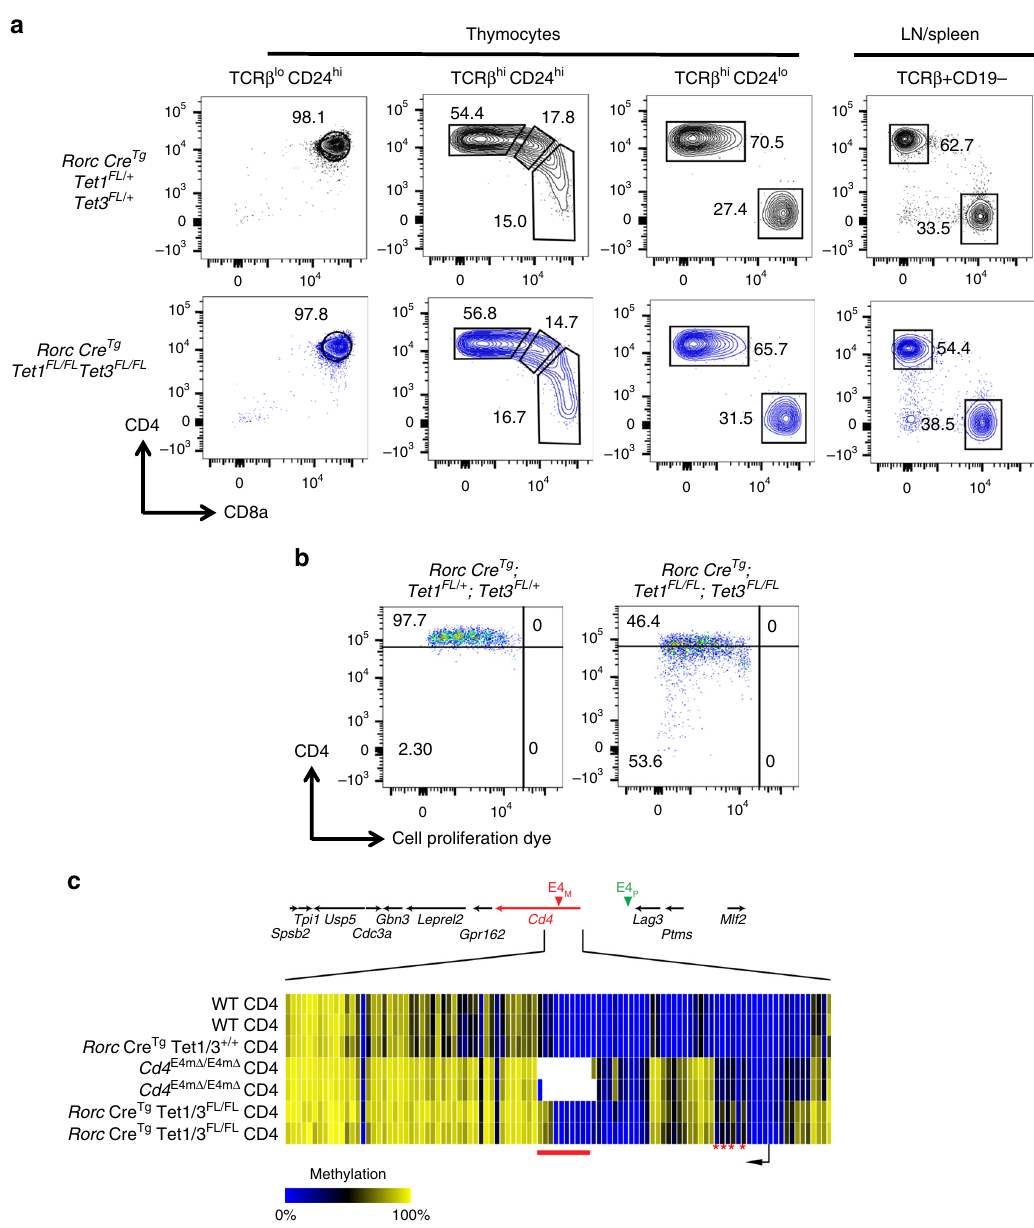
Fig. 6 TET1 and TET3 are required for E4m- and E4p-dependent demethylation of Cd4 . a FACS plots showing CD4 and CD8 expression in indicated cell subsets from RorcCre Tg Tet1 FL/FL Tet3 FL/FL and control littermate mice. Numbers in the FACS plot quadrants indicate cell percentages. Representative results of three independent analyses. b CD4 expression as a function of cell proliferation, measured by cell proliferation dye dilution, at 3 days after in vitro anti-CD3/anti-CD28 activation of sorted naive CD4 + T cells from mice with indicated genotypes. Numbers in the indicated gates represent cell percentages. Data are representative of more than three independent analyses. c Heatmaps depicting percent CpG methylation of residues within the region from + 6200 to − 669 relative to the Cd4 TSS (Chr6:124832027 – 124838896; mm9) in sorted activated CD4 + T cells 5 days post-activation, gating on CD4 mid-hi cells for Tet1/3 conditions and CD4 hi for Cd4 E4m Δ /E4m Δ conditions. A red line underlines CpGs in E4m (indicated by the gaps in the E4m mutant mice), and a black arrow indicates the Cd4 TSS. CATCH-seq was performed on genomic DNA from sorted populations. Red asterisks indicate 5mC marks that are lost in all conditions after cell